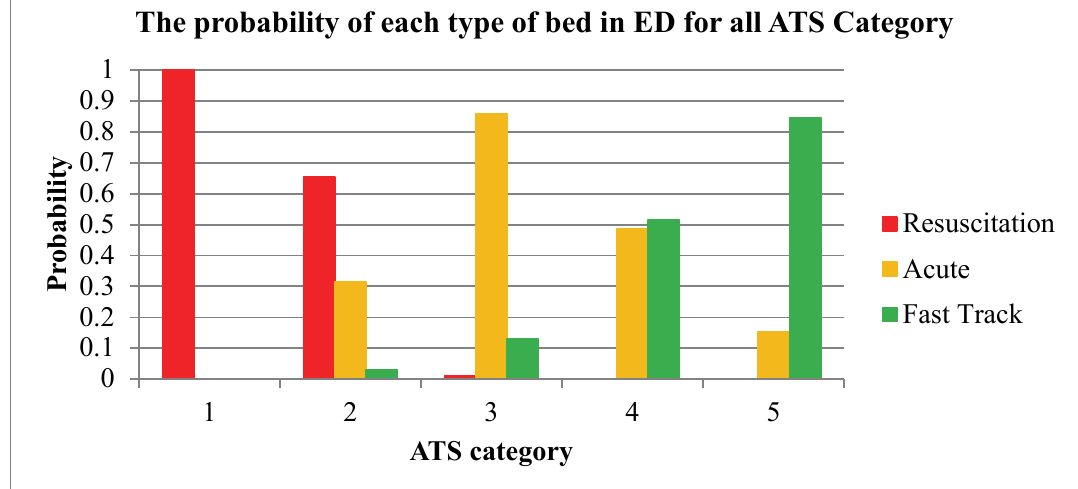
Fig. 5. The probability of each type of bed in ED for each ATS category